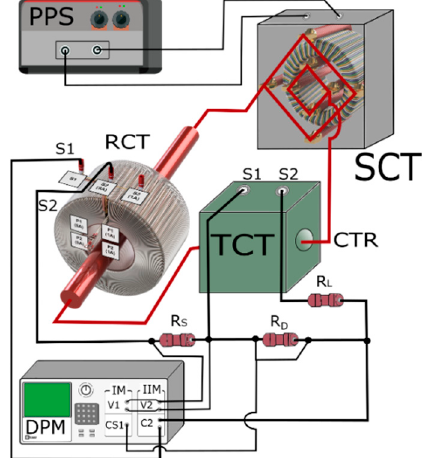
Figure 8. Measuring circuit used to determine the values of current and phase errors of the higher harmonics transformation between two CTs.